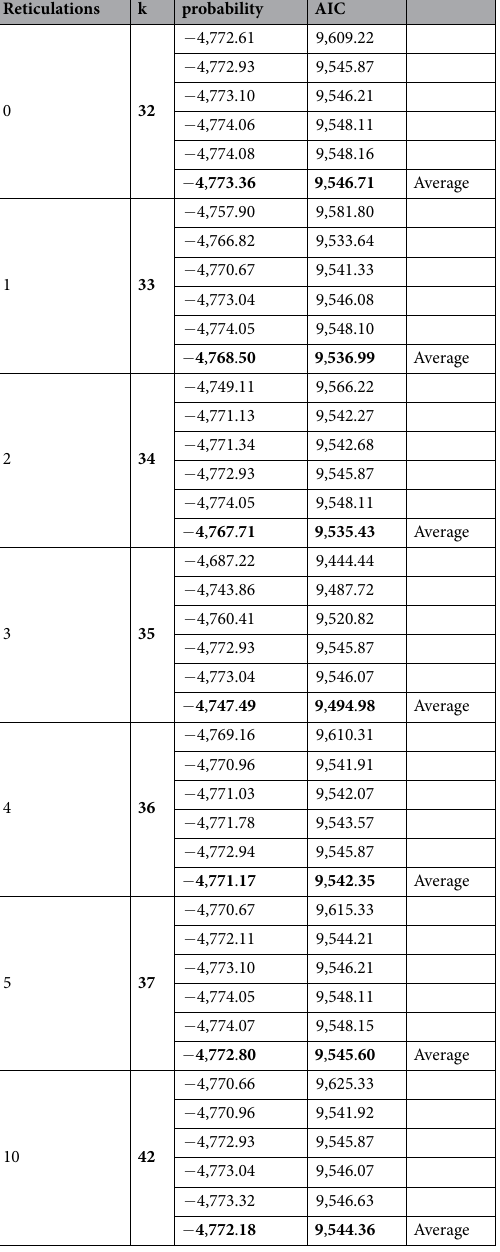
Table 2. Total log probabilities and AIC scores for different reticulation scenarios using the MPL